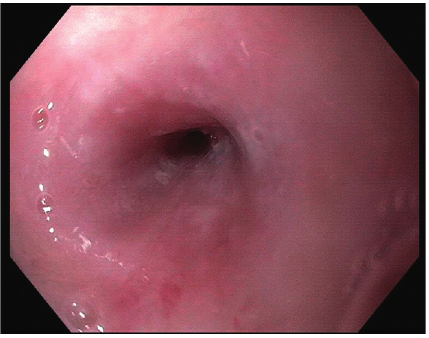
Figure 4: EGD revealing a pin-point esophageal in the midesophagus.